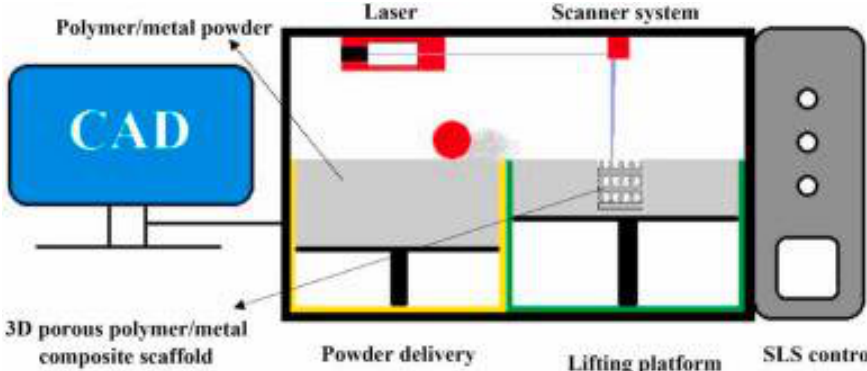
Figure 6. Schematic diagram of the SLS 3D printing technique for polymer/metal scaffolds.